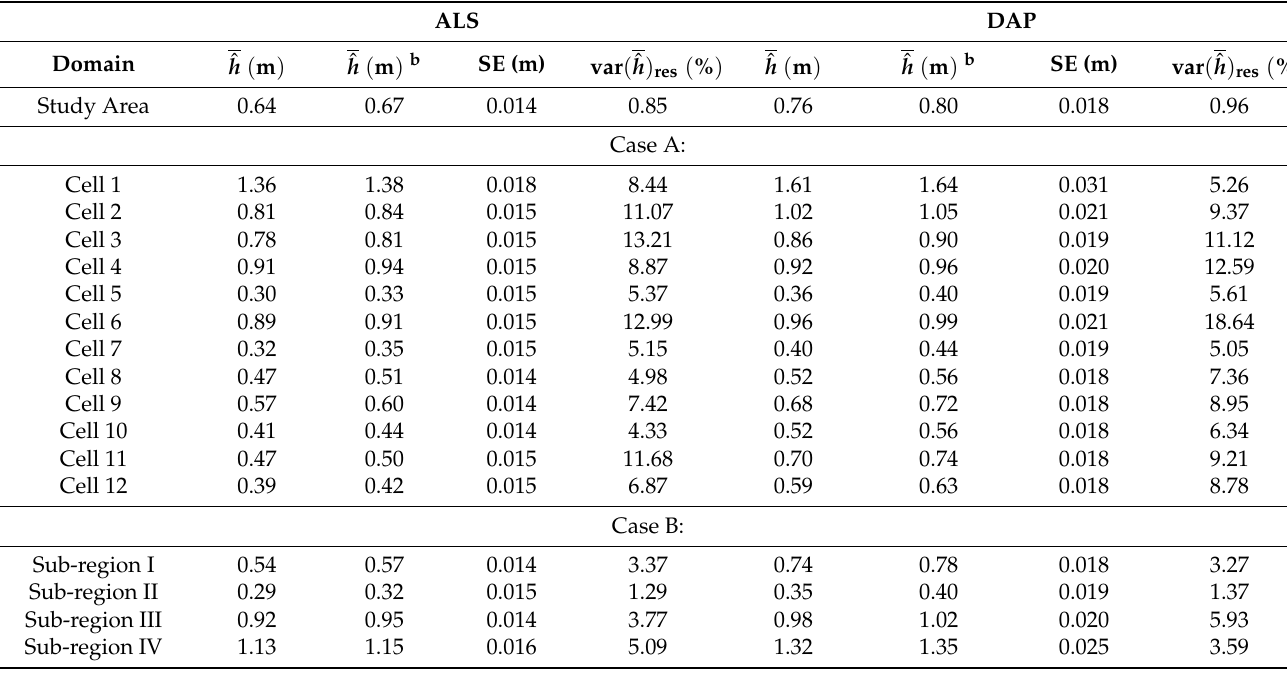
Table 11. Estimates of mean vegetation height (ˆ h ; Equation (6)) for various domains of the study area and corresponding standard error estimates a (SE), and contribution of the residual variance component (Equation (11)) to overall mean square error estimates of mean vegetation height (var(ˆ h ) res